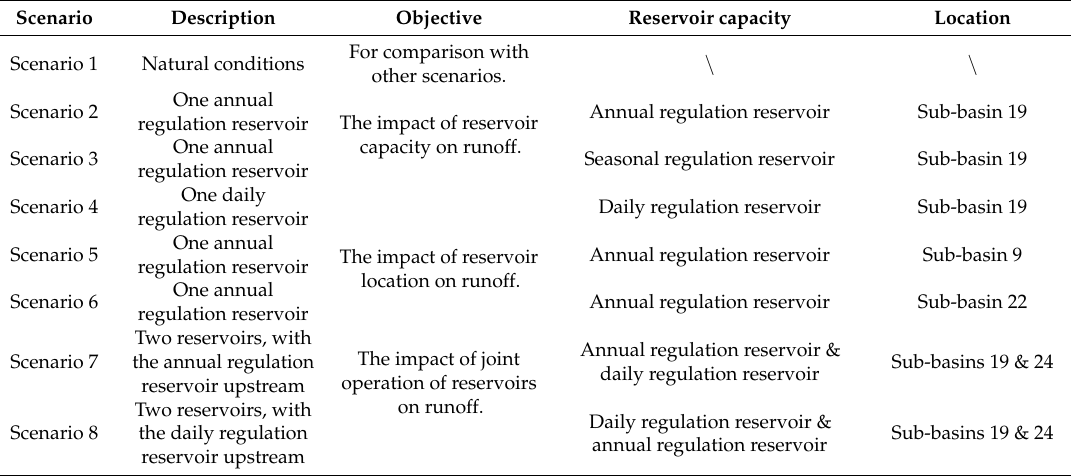
Table 3. The scenarios for this study.